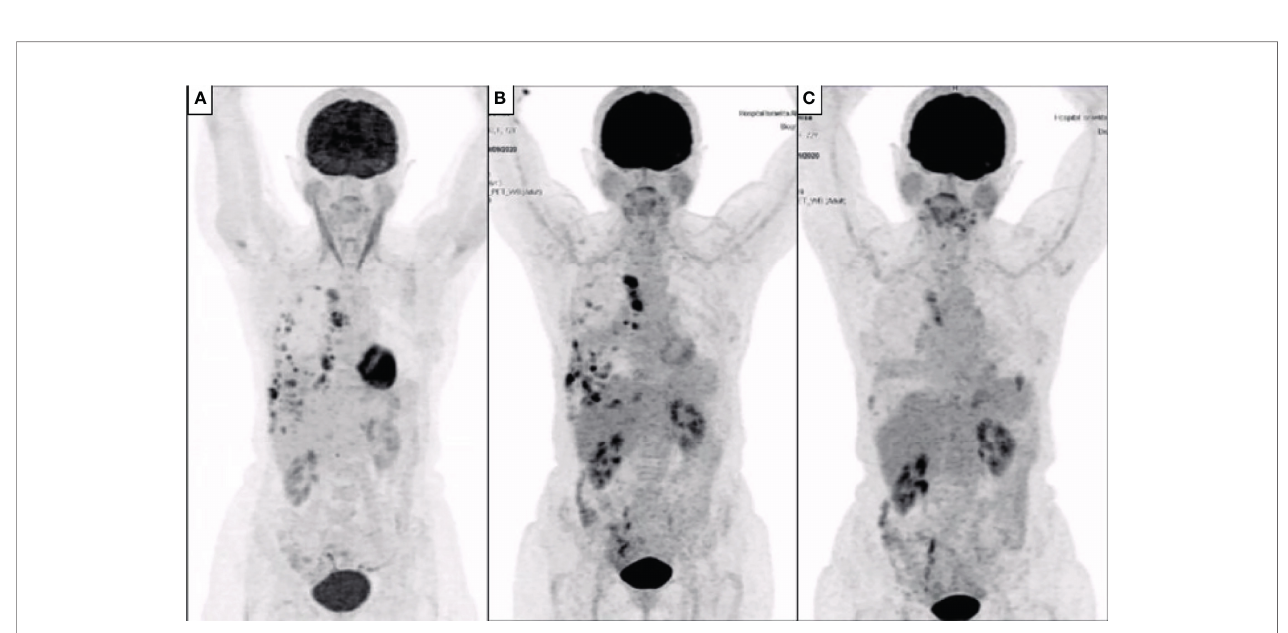
FIGURE 3 | PET-CT at baseline and during treatment. (A) Baseline PET-CT demonstrating right pleural implants and mediastinal lymph node involvement; (B) restaging PET-CT after 2 cycles of treatment showing improvement in pleural nodules, but enlargement of lymph nodes; (C) PET-CT after 4 cycles showing complete improvement in pleural implants, and near-complete improvement of lymph nodes.